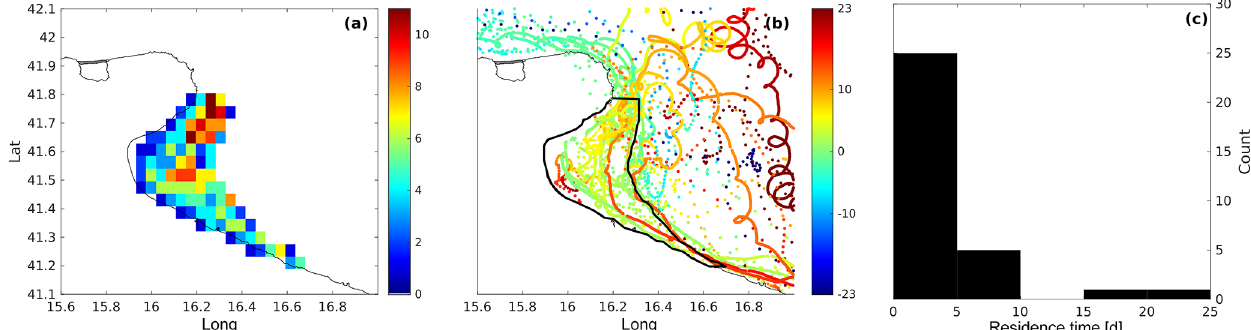
Figure 8. (a) Density of drifter data in the Gulf of Manfredonia, computed as the number of non-consecutive entries into each 0.044 ◦ bin. (b) Trajectories of drifters that entered the Gulf of Manfredonia color coded with respect to time of first entry in the gulf. The color scale corresponds to days before/after the first entry in the Gulf of Manfredonia. The boundaries of the gulf, as defined in Sect. 3.4, are represented by the thick black line. (c) Histogram of drifter residence times in the Gulf of